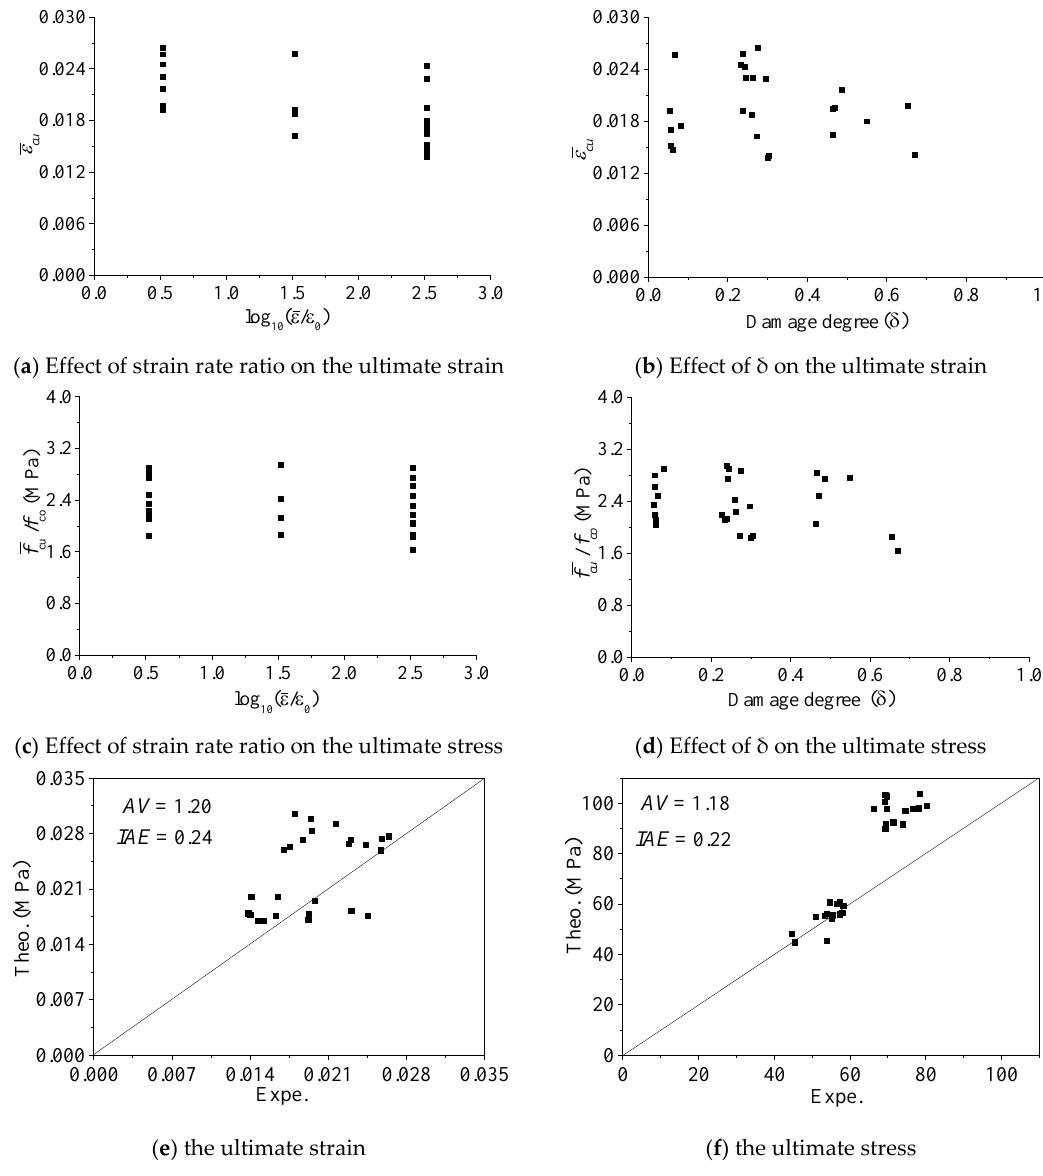
Figure 7. The ultimate state.